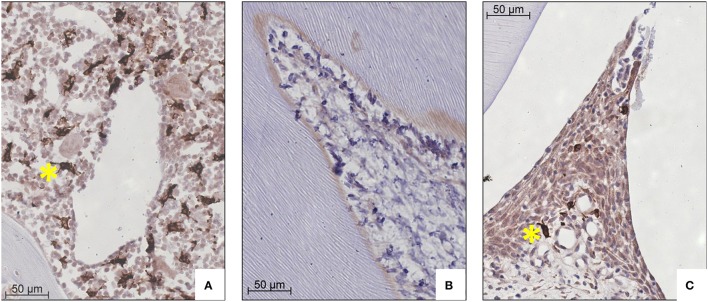
HO-1 expression in bone marrow, pulp tissue and interdental papilla tissue representative for both control and experimental group (HO-1 immunostaining, magnification: x400, yellow asterisk indicates a HO-1 overexpressing cell). (A) Large numbers of HO-1 overexpressing cells in bone marrow (control group 120 h). (B) Negligible numbers of HO-1 positive cells were present in pulp tissue (experimental group 12 h). (C) Few HO-1 positive cells in interdental papilla tissue (control group 120 h).